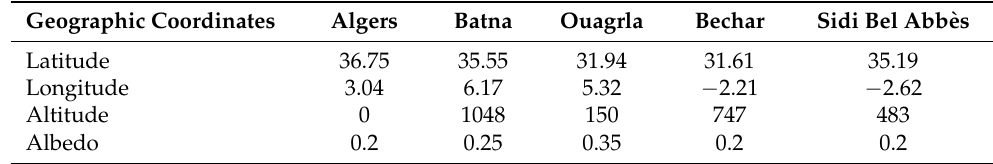
Table 1. Geographic data of study sites [5].